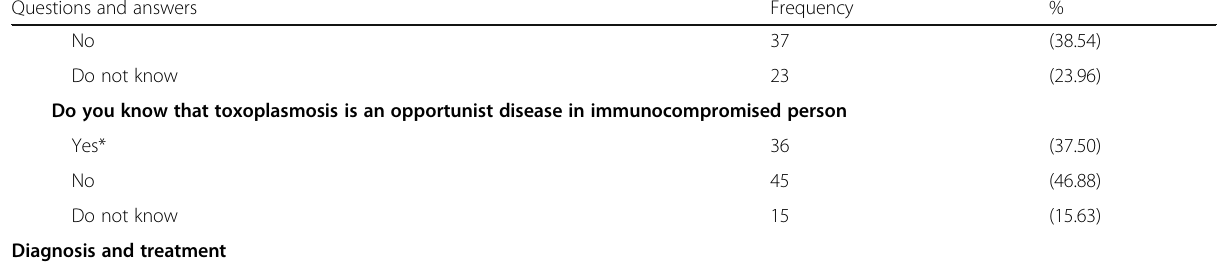
Table 2 Knowledge of parasite epidemiology, clinical aspects, diagnosis, and treatment of toxoplasmosis (Continued) Questions and